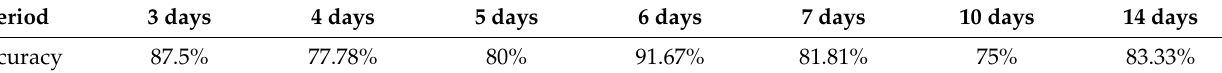
Table 2. Comparison of accuracy levels.